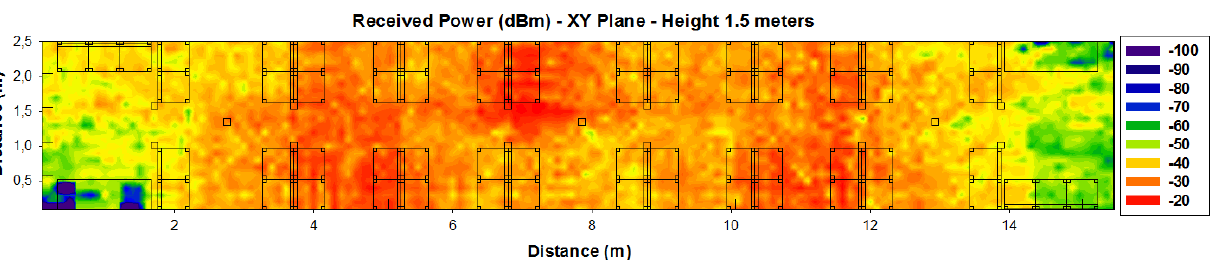
Figure 9. Estimation of received power (dBm) on the indoor passenger wagon train for height of 1.5 m obtained by full 3D Ray Launching algorithm.